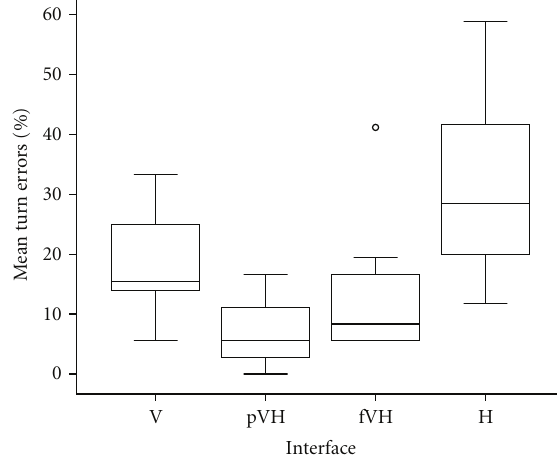
Figure 4: Boxplot showing the turn errors